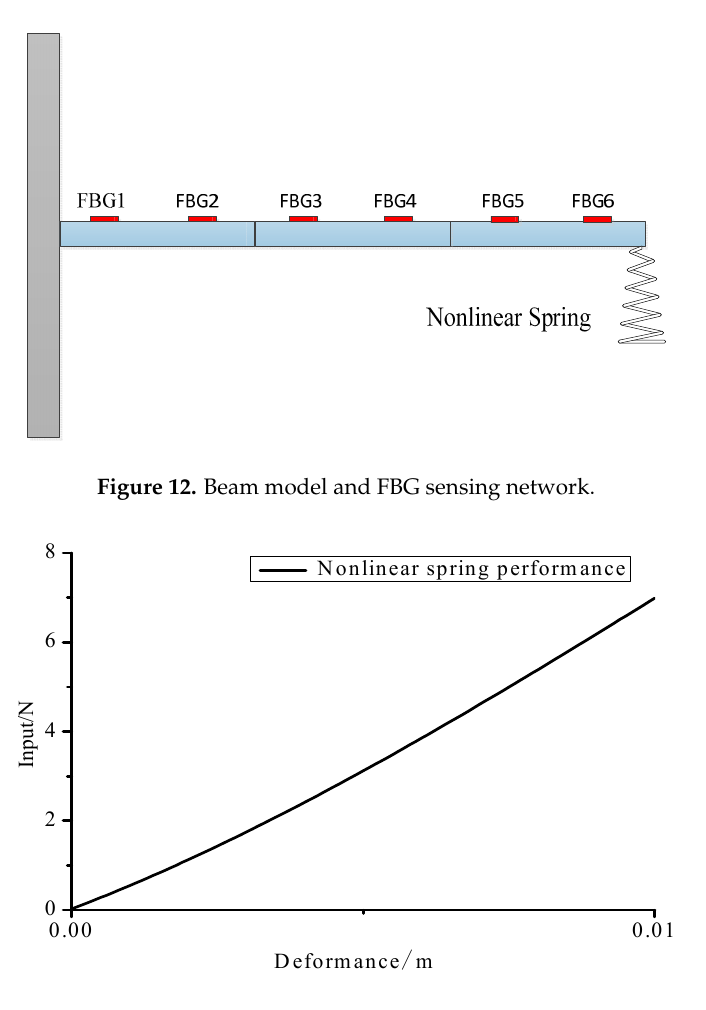
Figure 13. Nonlinear spring performance.